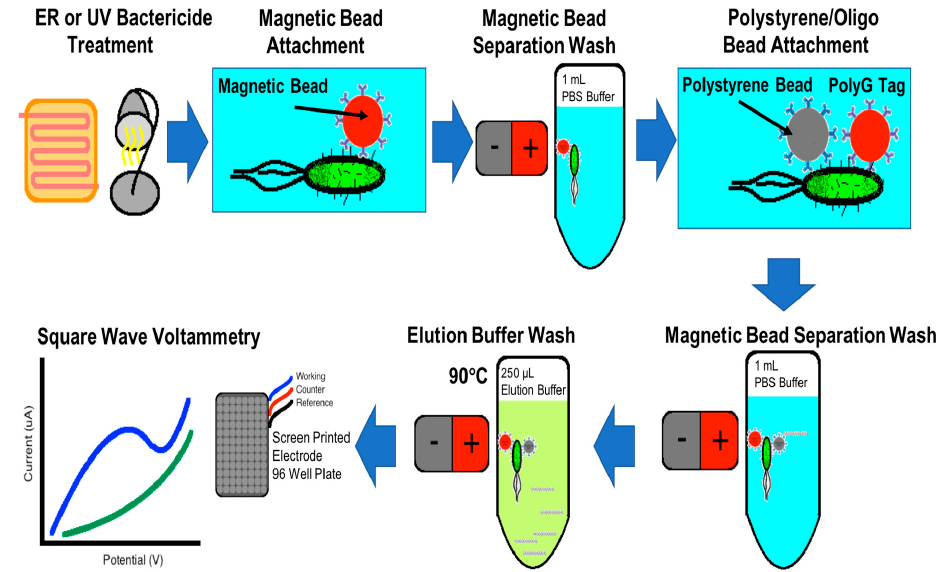
Figure 1. Immunomagnetic separation flowchart detailing the capture of the magnetic bead/ E. coli /polystyrene bead oligo sandwich assay for square wave voltammetry signal detection of E. coli .